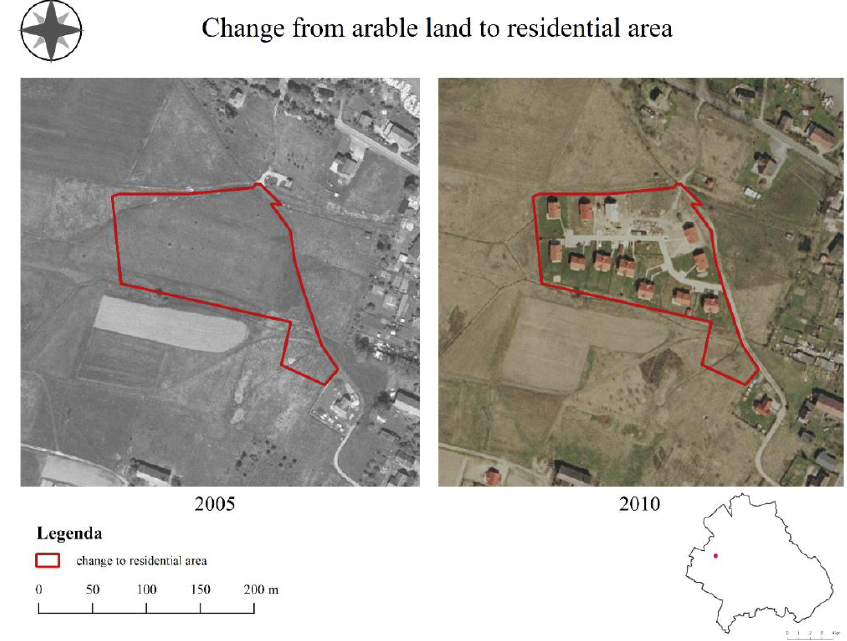
Figure 6. Urbanization in the Mysłakowice commune.